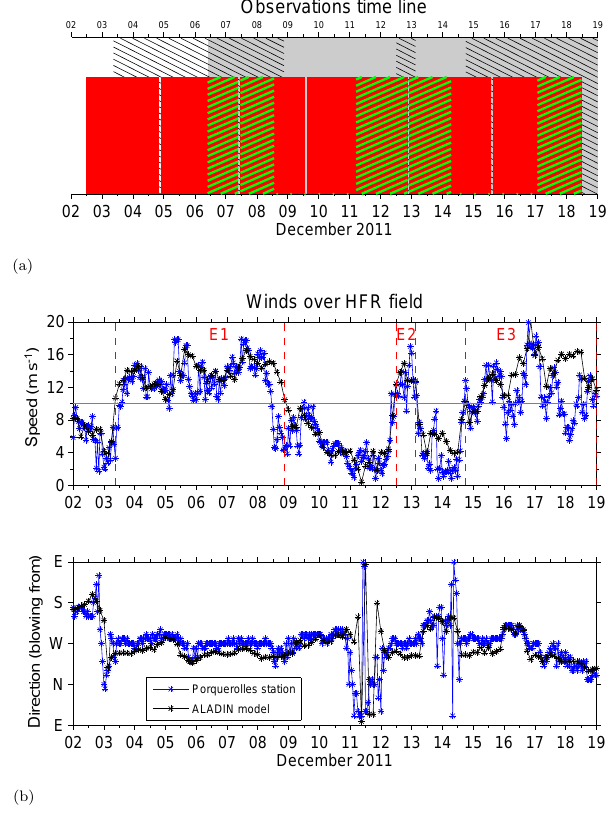
Figure 2. (a) The multi-platform observations timeline: the black dashed lines indicate the selected wind events (compare with the panel below), the gray area indicates the radar dataset availability, the red areas indicate the glider transects, and the green dashed lines indicate the period in which the glider transects fall inside the HF radar coverage. (b) Wind time series from Porquerolles weather sta- tion (blue line) and from the ALADIN model (black line) are com- pared in terms of speed (middle panel) and direction (bottom panel). The limits of the selected wind events (speed > 10ms − 1 , gray line in the middle panel) are indicated with red dashed lines and named E1, E2, and E3.